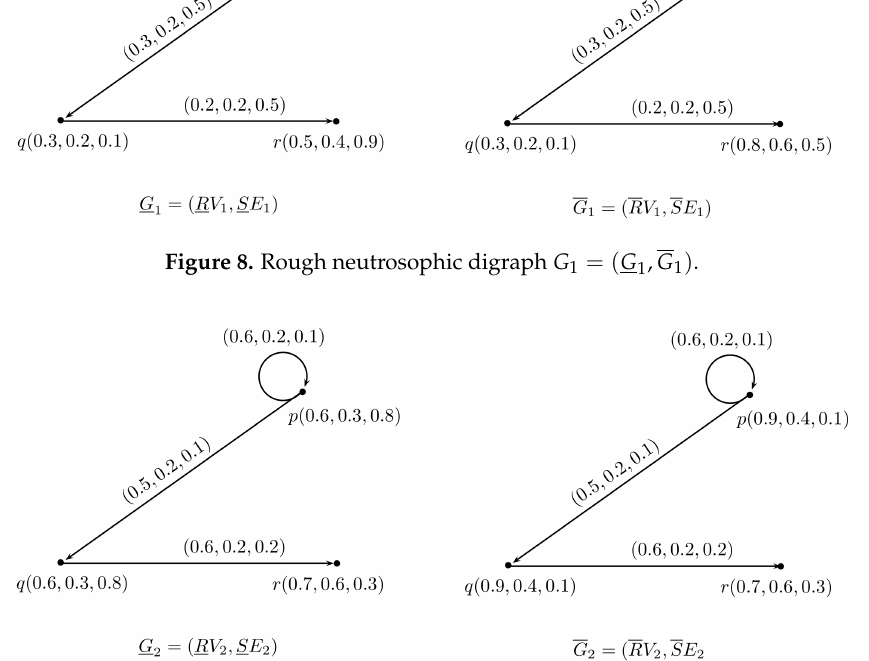
Figure 9. Rough neutrosophic digraph G 2 = ( G 2 , G 2 ) .